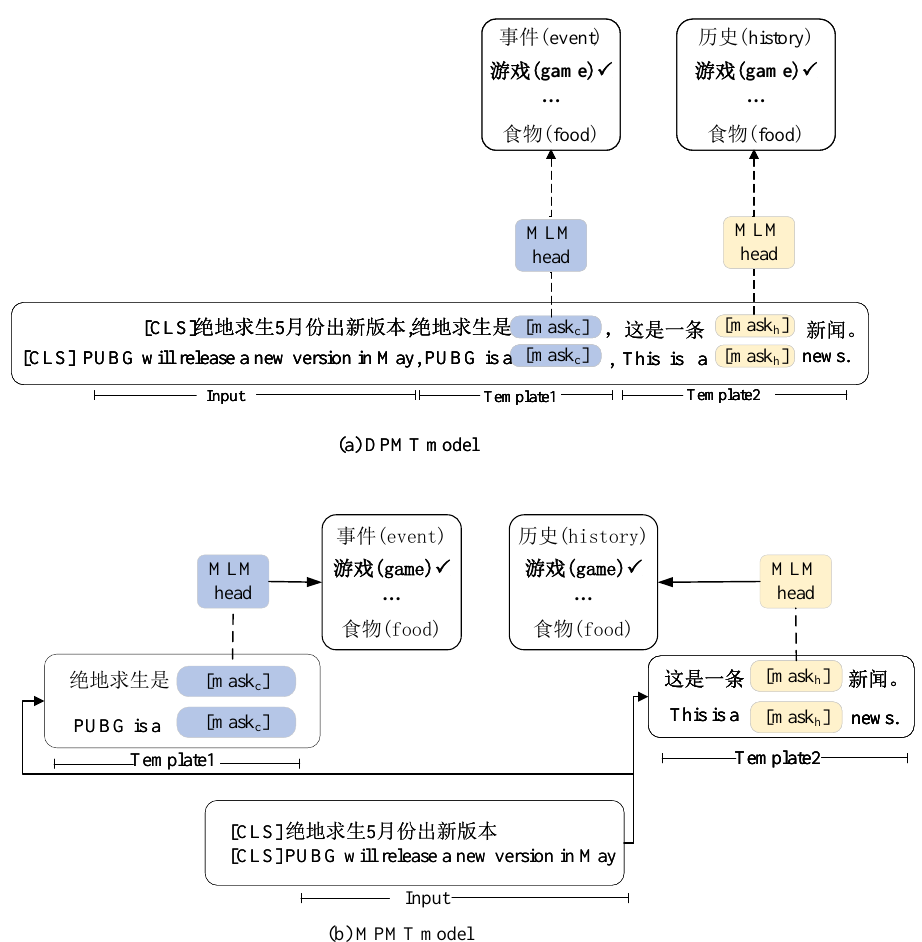
Figure 4. The proposed multi-task prompting models. In DPMT, knowledge probing and headline classification are processed in sequence and they share all the parameters. In MPMT, knowledge probing and headline classification are processed indepedently, they share the headline text with their own prompting